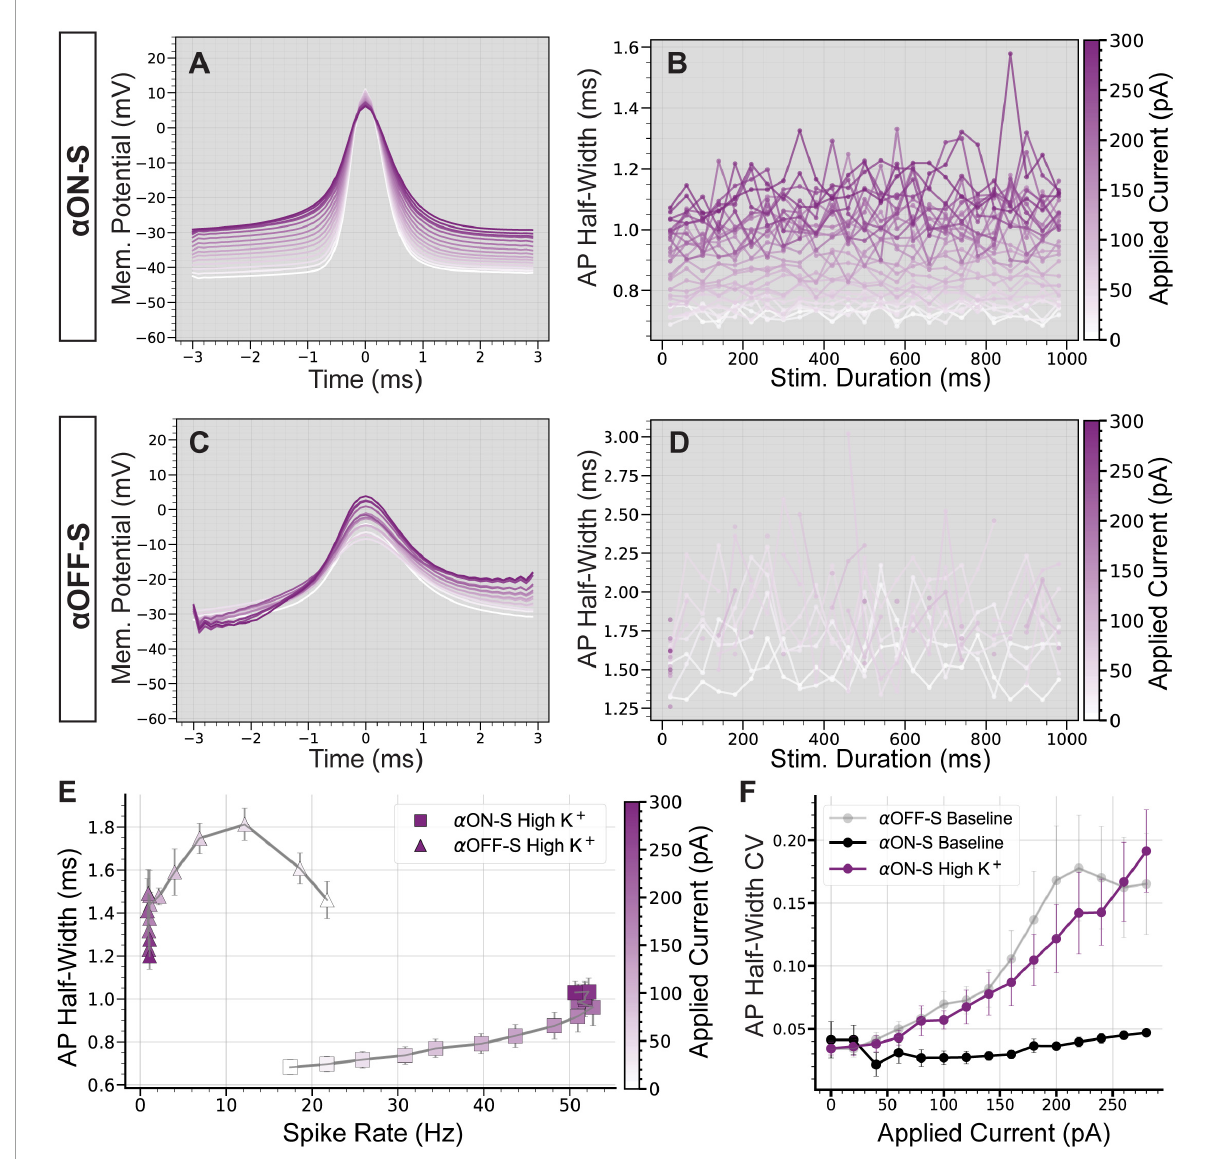
FIGURE6 Elevated extracellular potassium significantly alters action potential shape. (A) Mean action potential (AP) shapes for alpha ON-Sustained ( α ON-S) cells in high K + conditions at each current step. (B) Mean AP half-width vs. stimulus duration for each current level of high K + α ON-S cells. (C) Mean AP shapes for high K + alpha OFF-sustained ( α OFF-S) cells at each current step. (D) Mean AP half-width vs. stimulus duration for each current level of high K + α OFF-S cells. (E) The mean spike rate at each current injection vs. the AP half-widths for cells in high K +